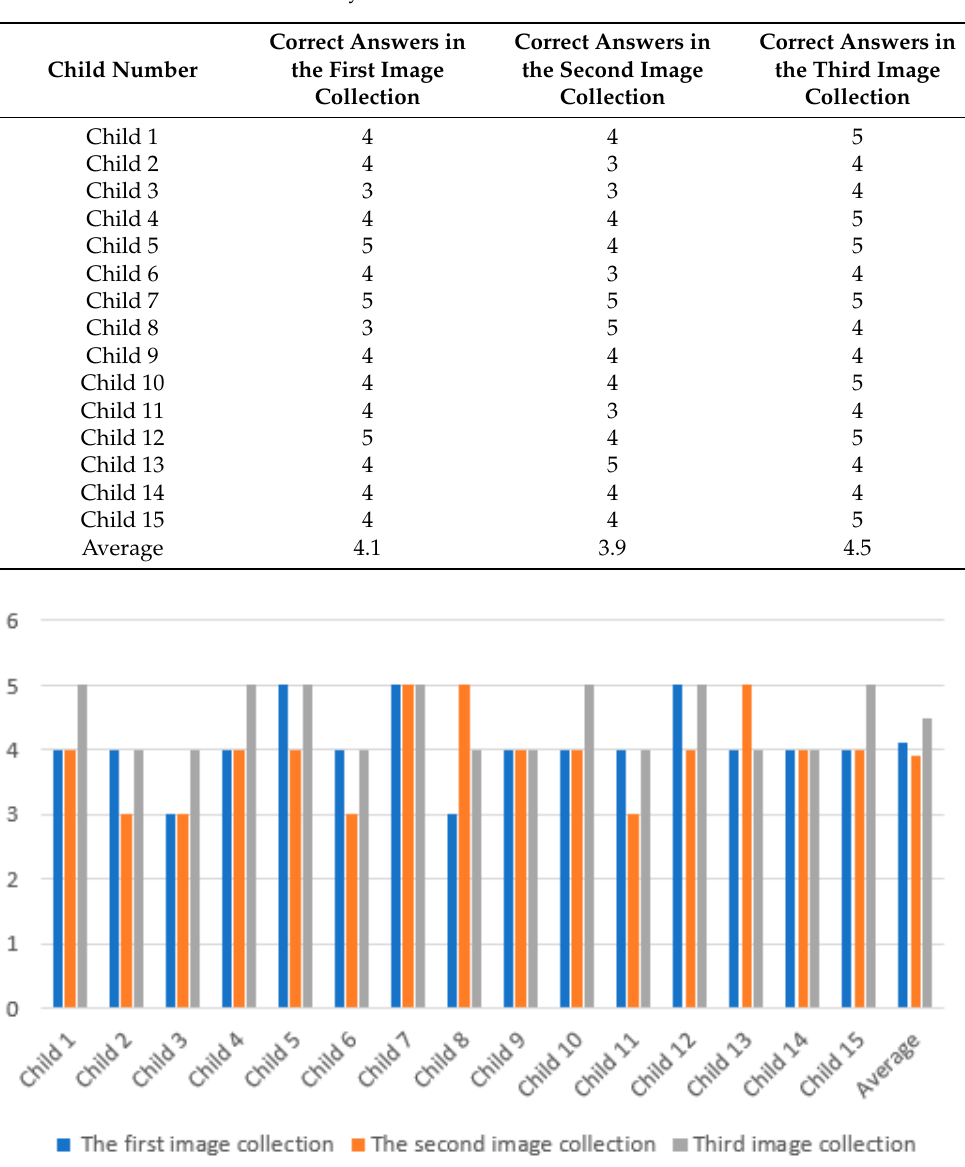
Figure 6. Correct answers in the TD children’s interaction with the three face collections on the first day. As shown in Table 2 and Figure 6, the maximum number of correct answers in the first image collection was 5 for child 5, child 7, and child 12, while the minimum number of correct answers in the first image collection was 3 for both child 3 and child 8. Overall, the average number of correct answers in the first image collection for the TD children was 4.1. In the second image collection, child 7, child 8, and child 13 achieved the highest number of correct answers with 5, whereas children 2, 3, 6, and 11 achieved the lowest number of correct answers with 3. In general, the average score for the second image collection for the TD children was 3.9. Interestingly, the minimum number of correct answers for the third image collection for the TS children was 4. As such, the average third image collection score for all of the children was